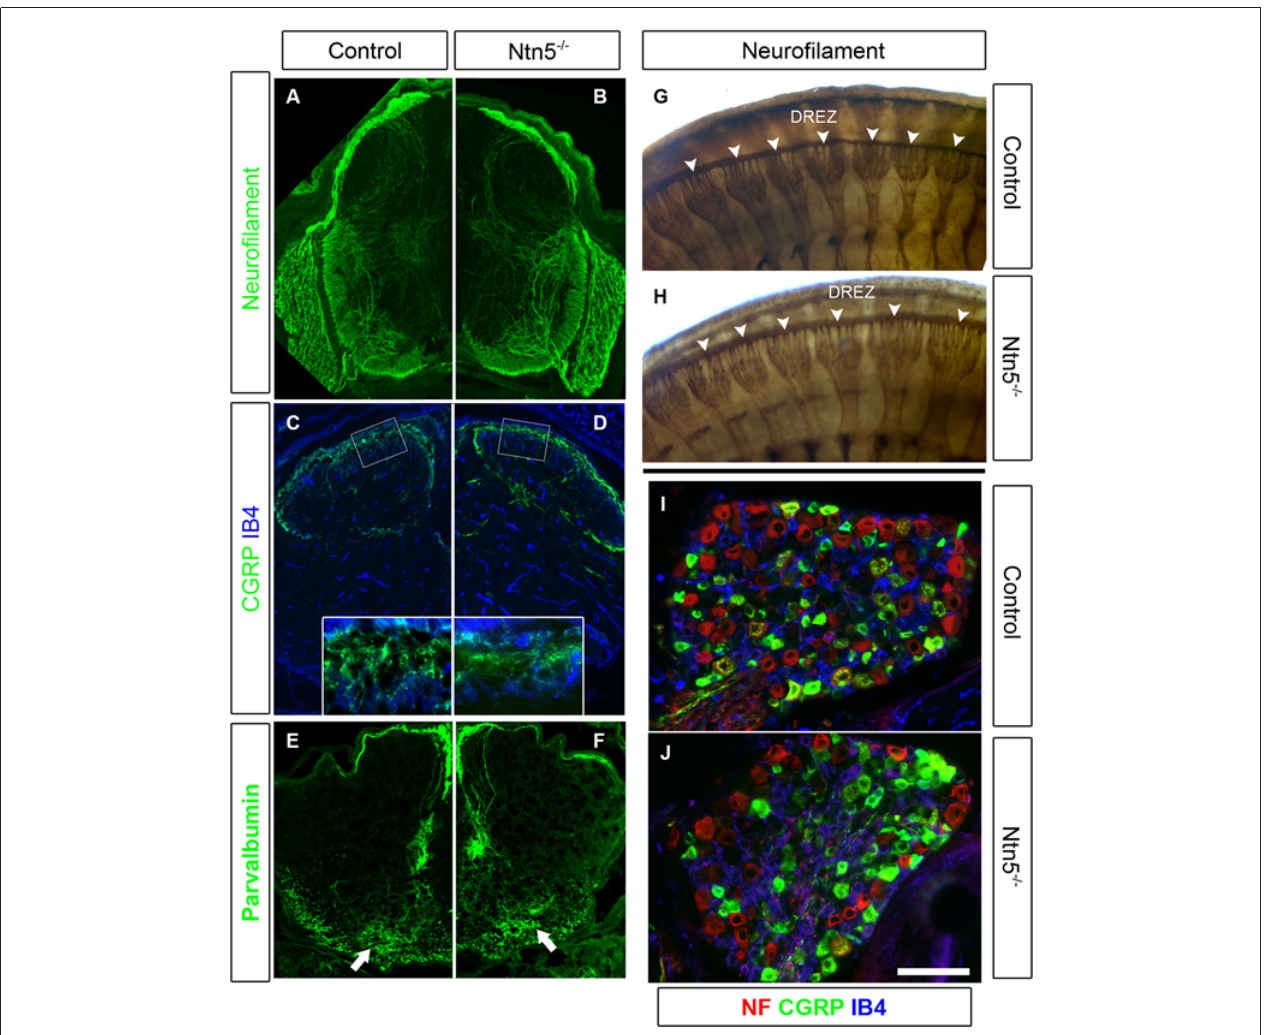
FIGURE 5 | Sensory neurons project through the DREZ without Ntn5 . There was no obvious disorganization of dorsal roots in Ntn5 − / − mutants visualized by immunolabeling for neurofilament in cryosections from E13.5 embryos (A,B) , or in whole embryo labeling at E11.5 ( G,H , arrowheads). Nociceptive fibers positive for CGRP and IB 4 projected into the superficial laminae at P3 in mutants and controls (C,D) , and parvalbumin-positive Ia afferents targeted to the motor neuron region normally ( E,F , arrows). There were also normal numbers of CGRP- and IB 4 -positive sensory neurons in mutant DRGs (I,J) . Scale bar is 400 µ m in (A − F) , 100 microns in insets (C,D) , and 100 µ m in (I,J)